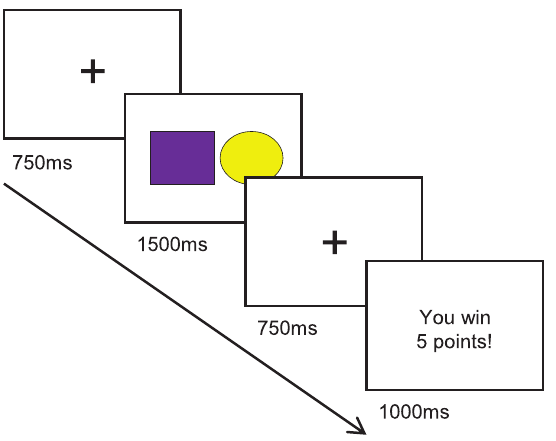
Figure 1. Task procedure. Each trial started with a fixation cross (750 ms) followed by the presentation of a screen including a circle and a square (one shape coloured yellow and the other purple) representing either a risky or safe choice. Participants made a selection between a risky and safe choice using a keypress. Next, another fixation screen was displayed and followed by a screen providing a feedback (1000 ms) detailing whether participants had won or lost points in the trial (see ‘‘Experimental task’’ for more